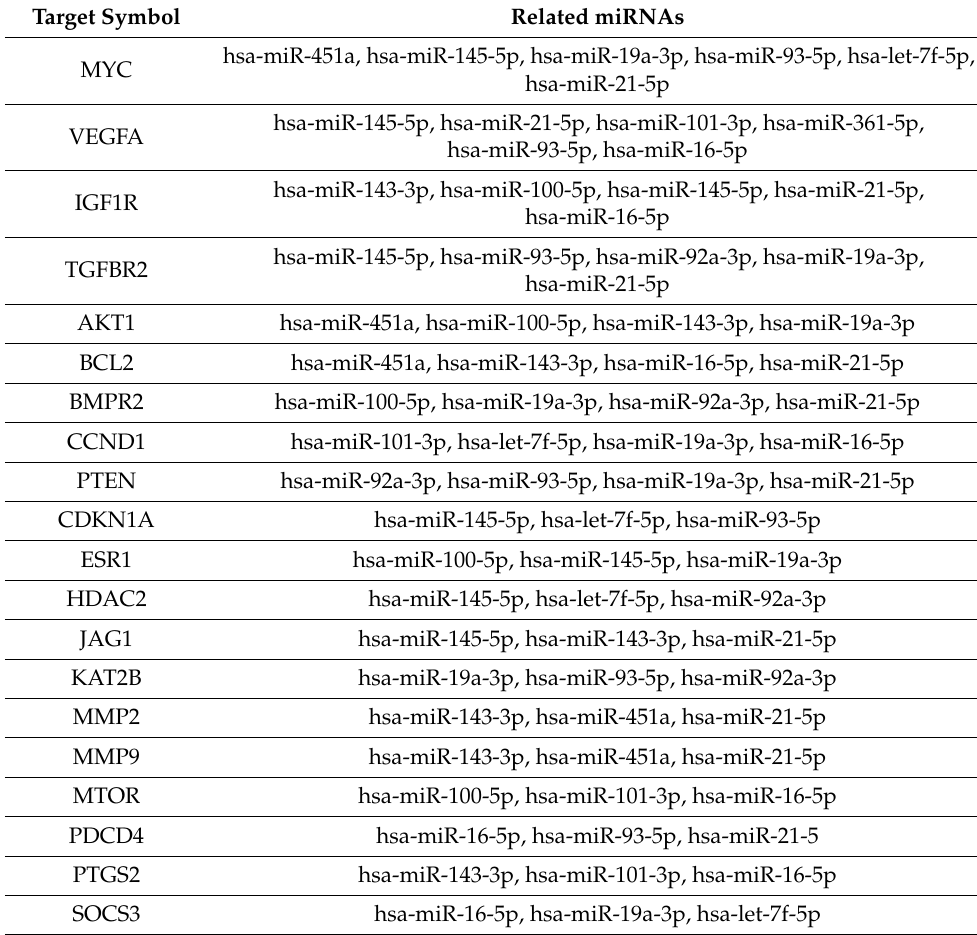
Table A1. MicroRNA (miRNA)–target relationships in shear stress-induced